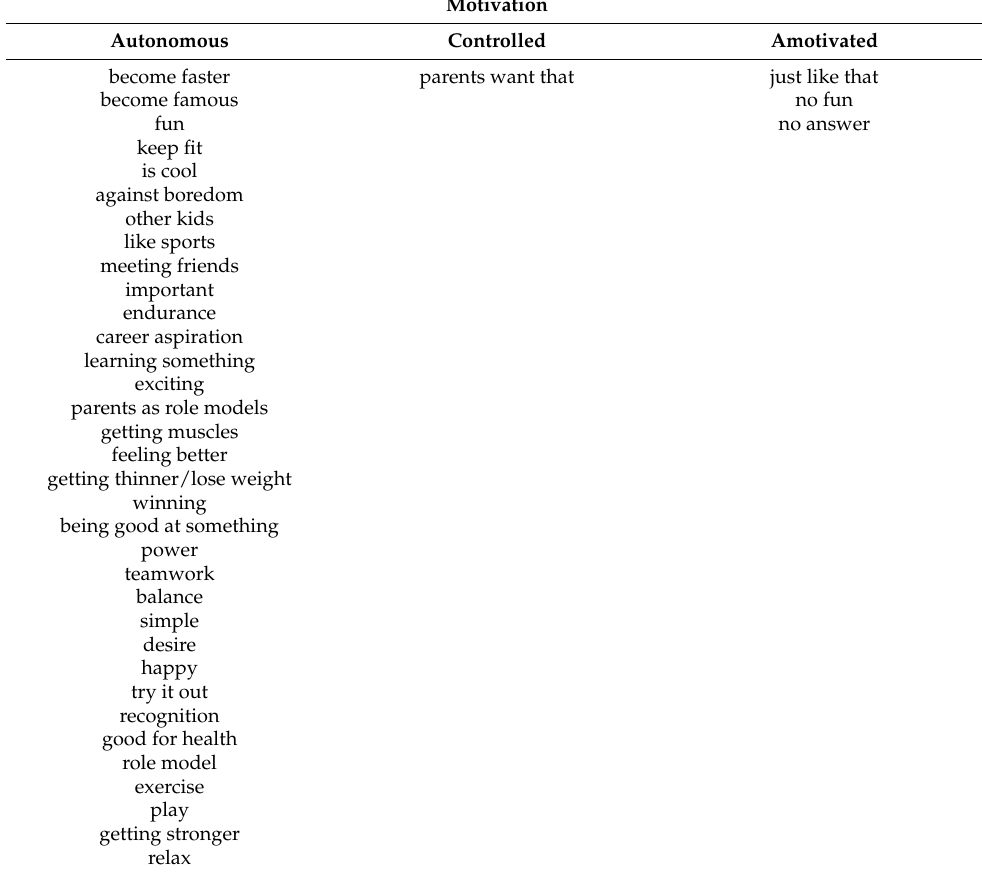
Table A1. Cluster of the subdomain